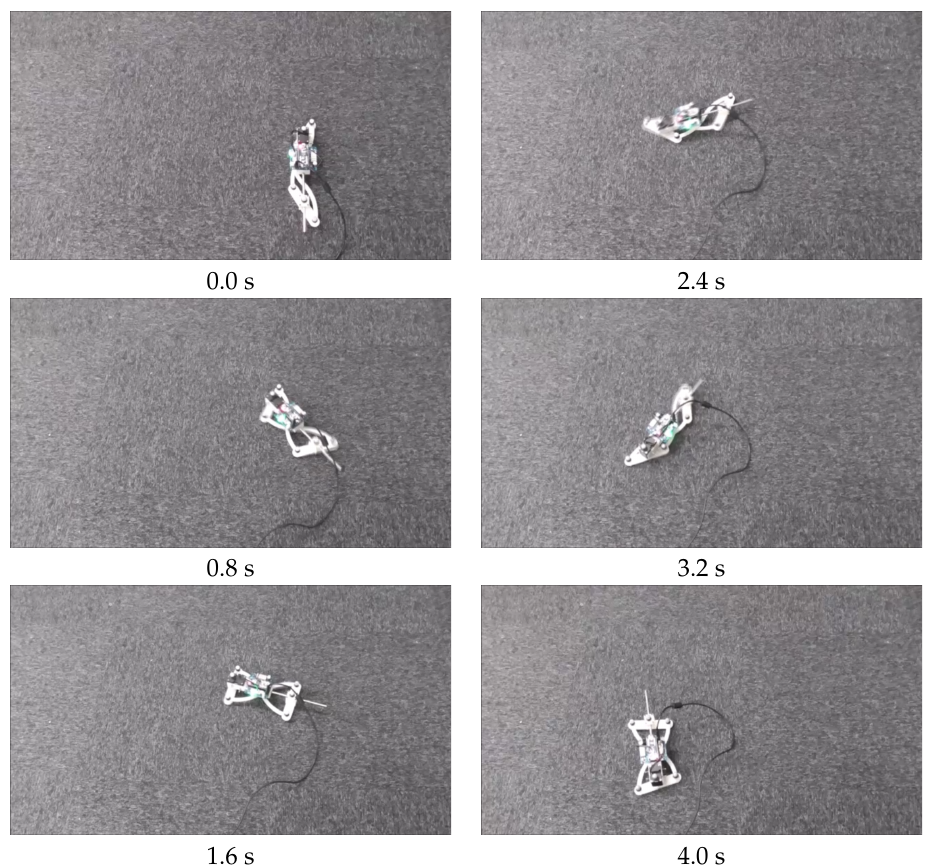
Figure 28. Snapshots of the counter-clockwise turning locomotion